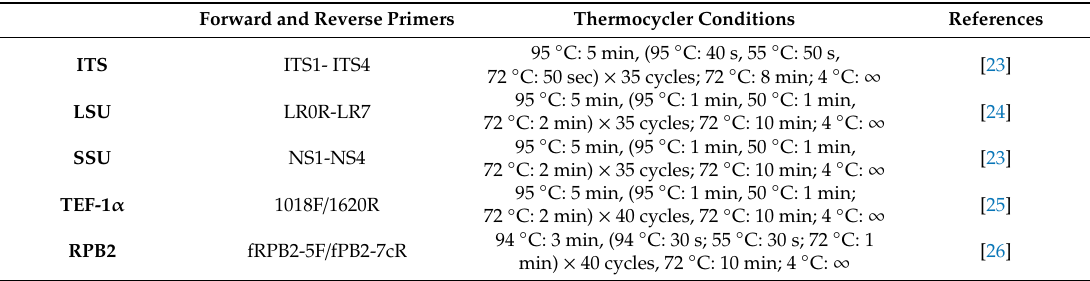
Table 2. Primers and PCR conditions used to amplify specific gene